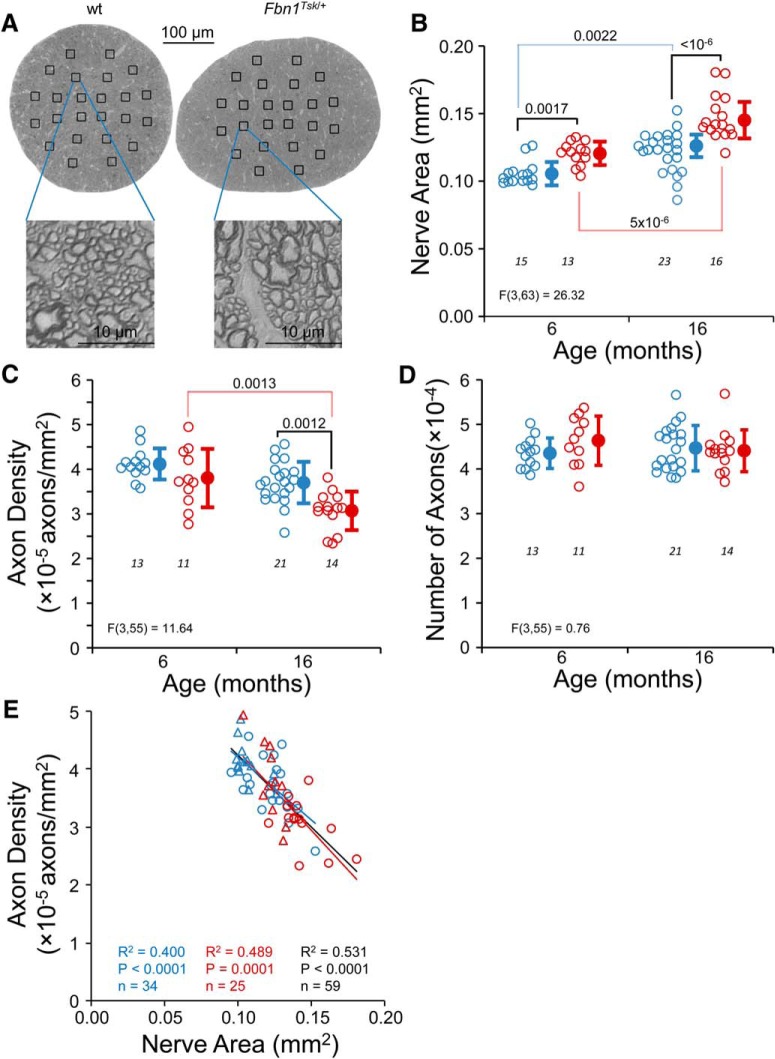
Enlargement of optic nerves in Fbn1Tsk
/+ mice. In optic nerve cross sections (A), Fbn1Tsk
/+ mice appeared to have larger nerves and axons compared to wt. Optic nerve area significantly increased with age for both wt and Fbn1Tsk
/+ mice and was significantly larger at both ages for Fbn1Tsk
/+ mice as compared to wt (B). Average axon density, determined manually by counting axons within boxes (A) was significantly lower in Fbn1Tsk
/+ mice (C). However, the total number of axons was not different in wt and Fbn1Tsk
/+ nerves (D). Axon density was significantly correlated with nerve area (E; triangles, six months; circles, 16 months). Blue symbols, wt; red symbols, Fbn1Tsk
/+. Closed symbols, mean ± SD. Numbers of mice indicated in italics below each group (B–D). The best-fit line, R
2, p value, and number of data points are shown for wt and Fbn1Tsk
/+ mice separately and for all mice combined (E, red, blue and black lines and text, respectively).